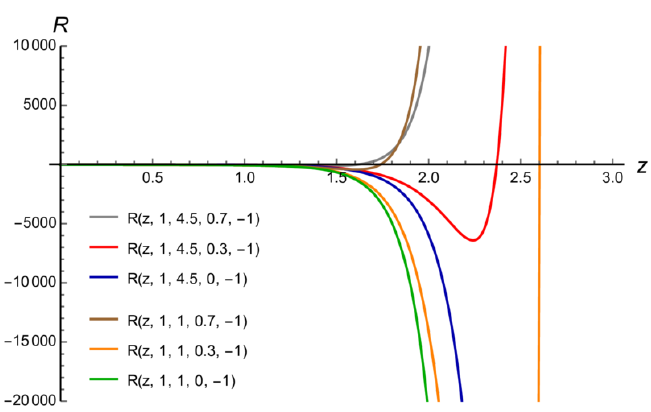
Figure 9 . Ricci scalar R ( z ) for z h = 1, c = (cid:0) 1 in isotropic, (cid:23) = 1, and anisotropic, (cid:23) = 4 : 5, cases for di(cid:11)erent (cid:22) .